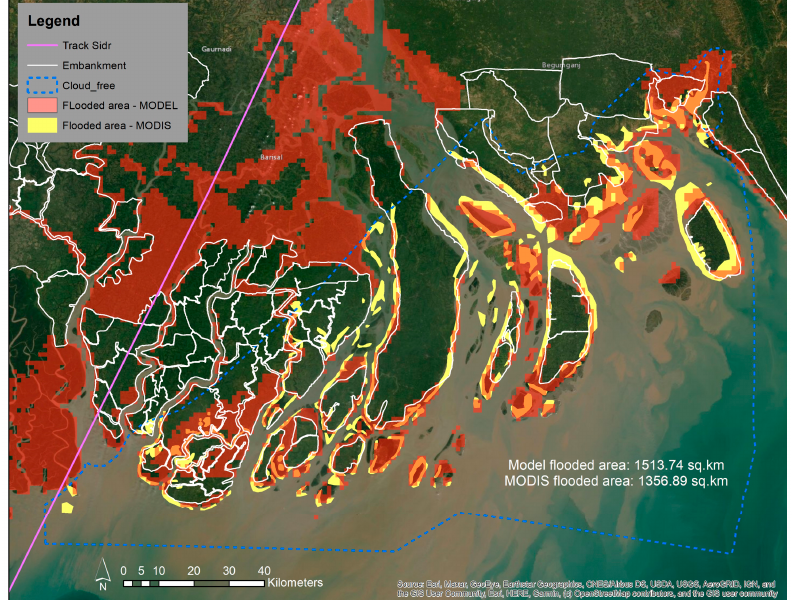
Figure 8. Model cyclone flood area comparison with the flood area analyzed from MODIS imagery at 0000 UTC on 16 November by the Dartmouth Flood Observatory. The blue dashed line indicates the cloud-free area in MODIS imagery. The white solid lines indicate embankment locations. The nearest station to the track of Cyclone Sidr (Khepupara) is denoted by the star. The area of flooding analyzed from MODIS imagery is reproduced from the map prepared by the Dartmouth Flood Observatory (https://reliefweb.int/map/bangladesh/bangladesh-cyclone-sidr-rapid-response-inundation- map-16-nov-2007, accessed on 8 September